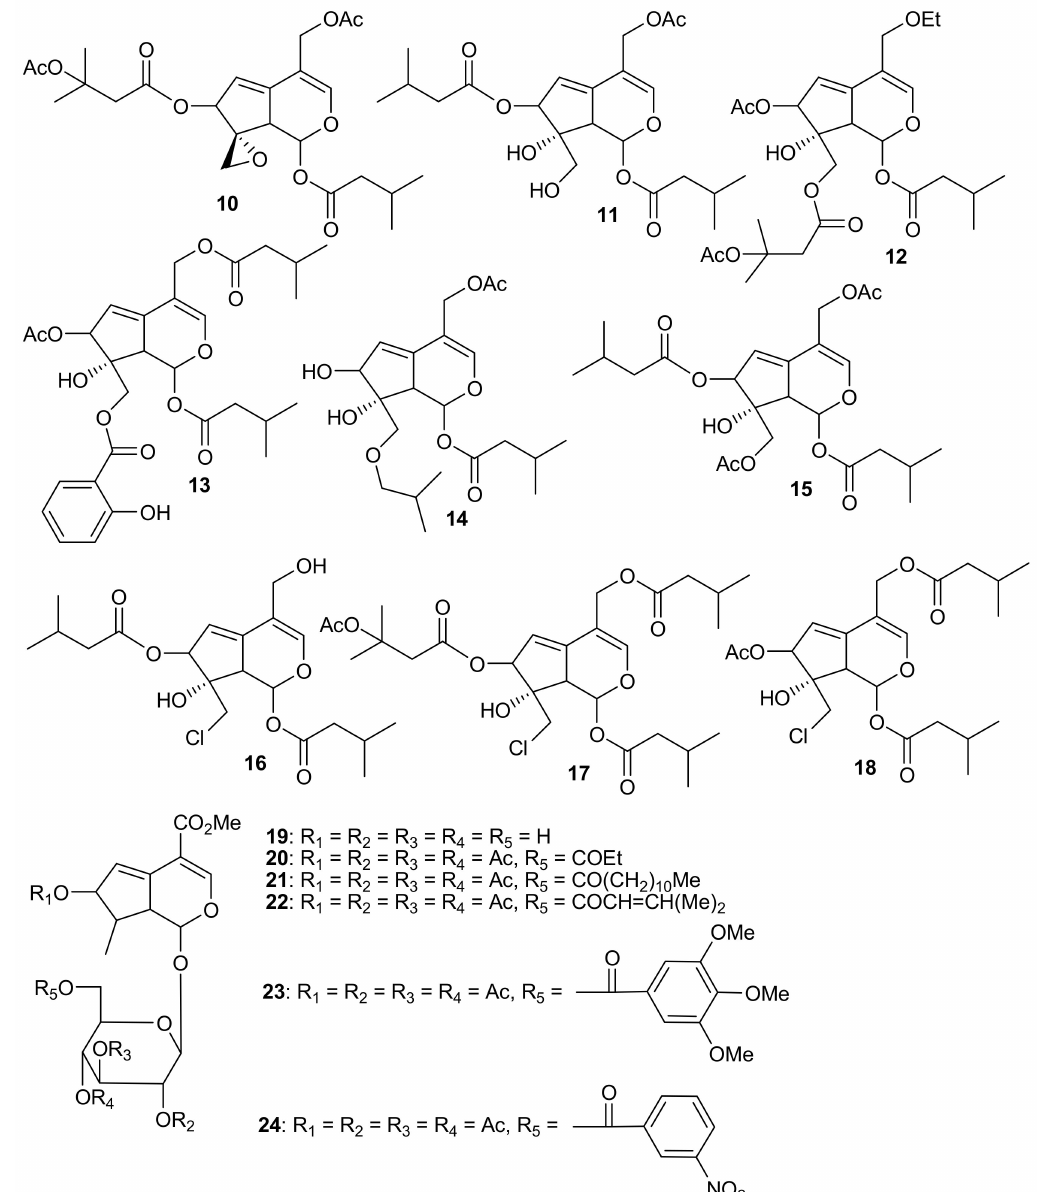
Figure 4. Structures of cytotoxic iridoids 10 – 24